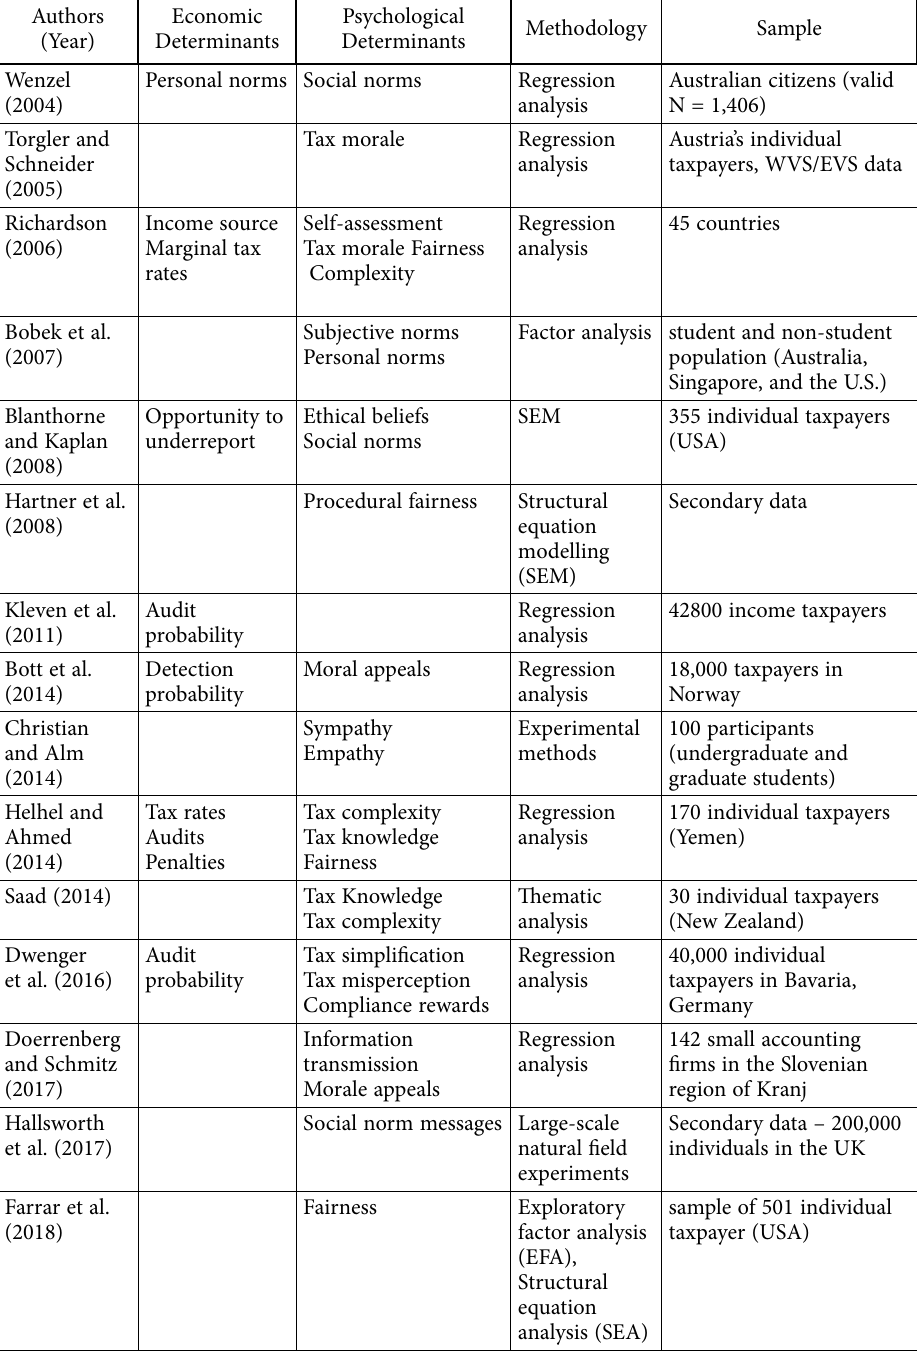
Table 1. Prior research on tax compliance determinants (source: authors’ own compilation, 2021) Authors